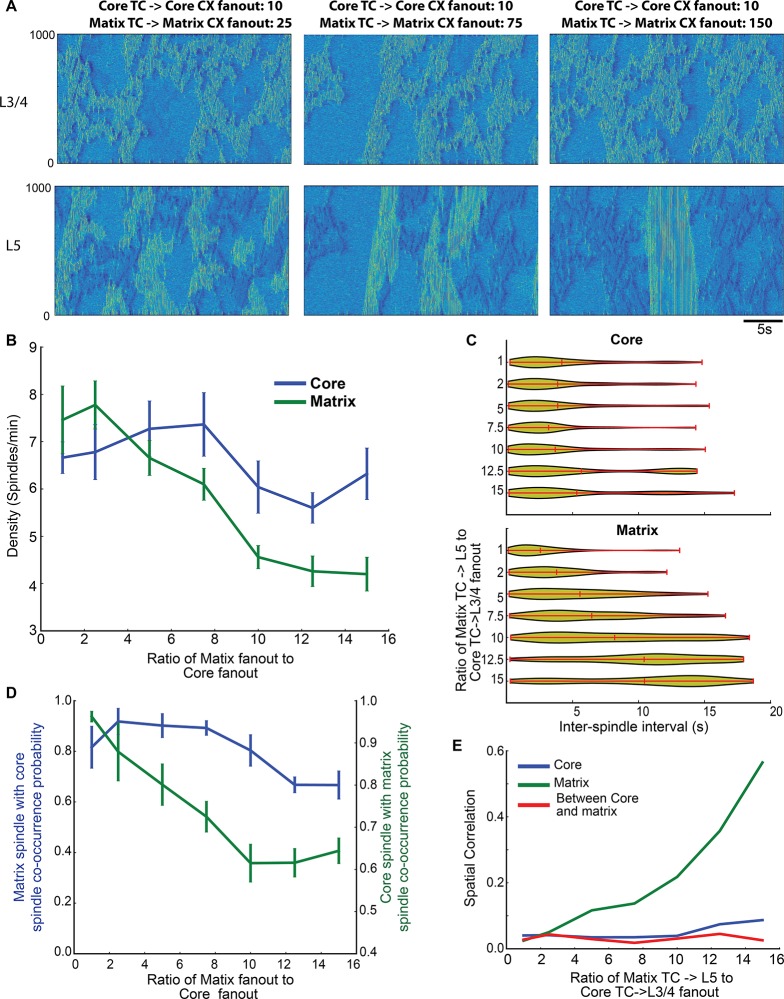
Effect of thalamocortical connectivity on spindle properties.(A) Space-time plots of network activity in cortical layers for different fanout of the thalamocortical and corticothalamic connections. (B) Spindle density for different fanout conditions. The X-axis shows the ratio of thalamic projection fanout in the matrix system to that in the core system. The actual thalamocoritcal and corticothalamic radii for the different ratios (1,2.5, 5, 7.5, 10, 12.5, 15) were 10/2/10/2 (core TC->L3/4, L6->core TC, matrix TC->L5, L5->matrix TC), 10/2/25/5, 10/2/50/10, 10/2/75/15, 10/2/100/20, 10/2/125/25, 10/2/150/30. (C) Violin plots showing the distribution of inter-spindle intervals as a function of thalamocortical fanout. (D, E) Probability of spindle co-occurrence between core and matrix, and spatial correlation as a function of synaptic fanout.